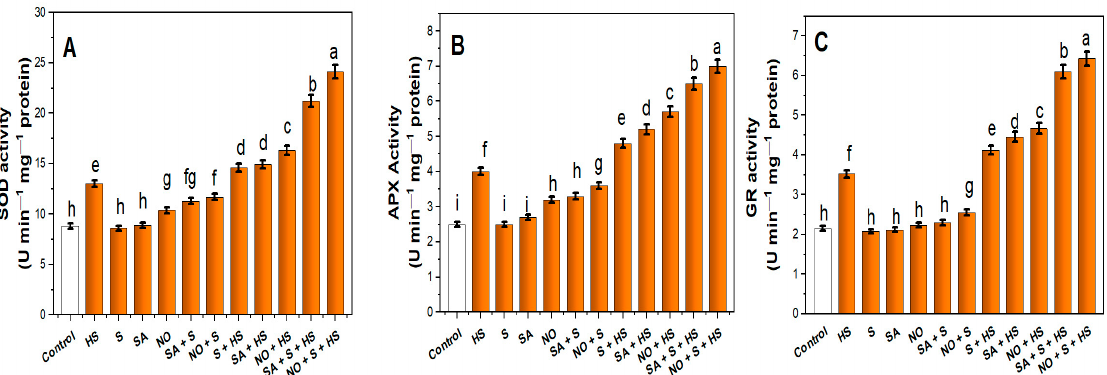
Figure 2. Activity of ( A ) superoxide dismutase (SOD), ( B ) ascorbate peroxidase (APX) and ( C) glutathione reductase (GR) in wheat ( Triticum aestivum L.) cv. HD-3226 treated with 0.5 mM salicylic acid (SA) and/or 50.0 µM nitric oxide (NO)/2.0 mM SO 4 − 2 (S) individually or in combination in the presence or absence of heat stress (HS; 40 °C for 6 h daily for 15 days) at 30 days after germination. Data are presented as treatment mean ( n = 4). Data followed by the same letter are not significantly different by the LSD test at p ≤ 0.05. FW, fresh weight.